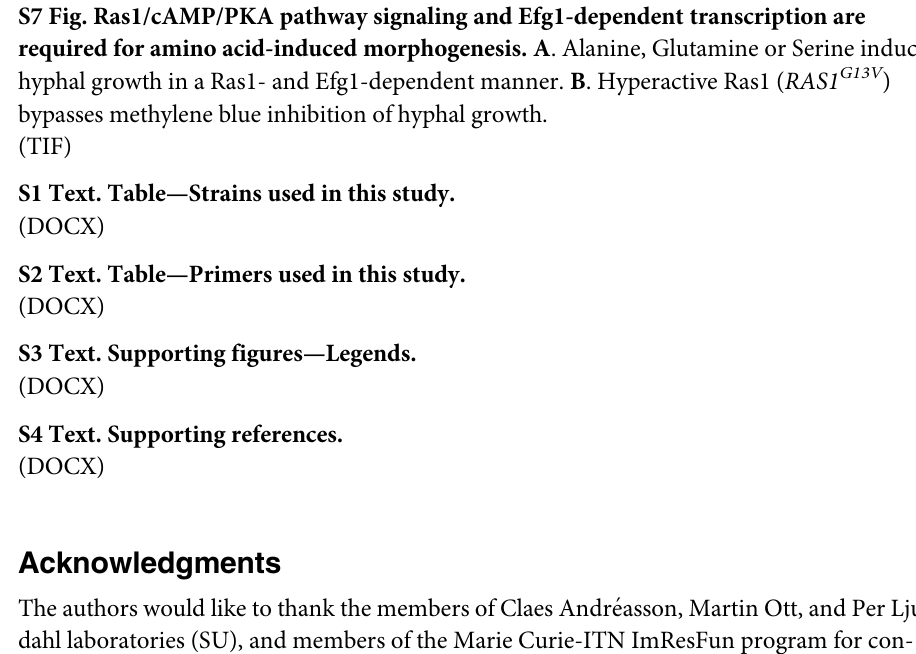
S4 Fig. Growth curves of arginine catabolic-pathway mutants in different nitrogen sources. (TIF) S5 Fig. Mutants lacking DUR1 , 2 retain the ability to alkalinize the growth medium when using arginine as sole carbon and nitrogen source. S6 Fig. Mitochondrial oxygen consumption is carbon source dependent. A . Oxygen con- sumption of C . albicans wildtype cells (PMRCA18) grown in synthetic proline medium con- taining 2% glucose (SPD), 0.2% glucose (SPD ) or 1% glycerol (SPG). B . Inhibitors of 0.2% mitochondrial oxidative phosphorylation used to control assessment of oxygen consumption. S7 Fig. Ras1/cAMP/PKA pathway signaling and Efg1-dependent transcription are required for amino acid-induced morphogenesis. A . Alanine, Glutamine or Serine induce hyphal growth in a Ras1- and Efg1-dependent manner. B . Hyperactive Ras1 ( RAS1 G13V ) bypasses methylene blue inhibition of hyphal growth.